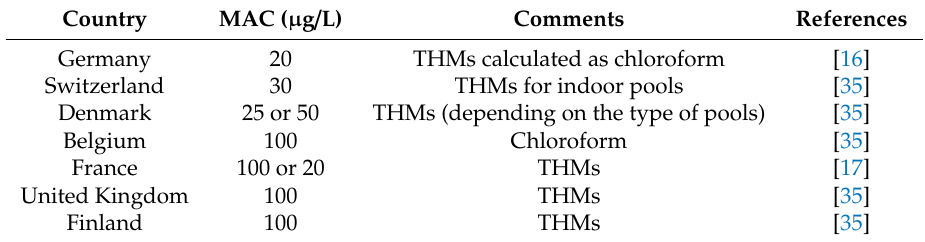
Table 4. Maximum allowed concentrations (MAC) of THMs in swimming pool water in several European countries